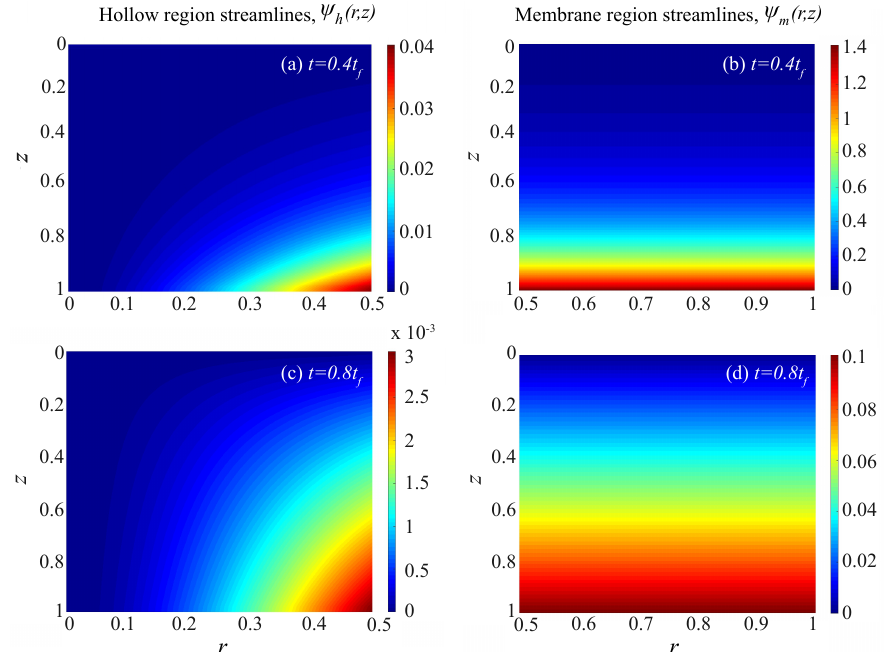
Figure 3. Contour plots showing the streamlines at time t = 0.4 t f in ( a ) the hollow region and ( b ) in the membrane region. Plots ( c , d ) show the streamlines in the hollow region and membrane region, respectively, at time t = 0.8 t f . Parameter values are φ = 0.5, l = 0.5, Γ = 10, N = 1, β = 0.02, ρ b = 2, b = 0.5, and (cid:101) ∗ =